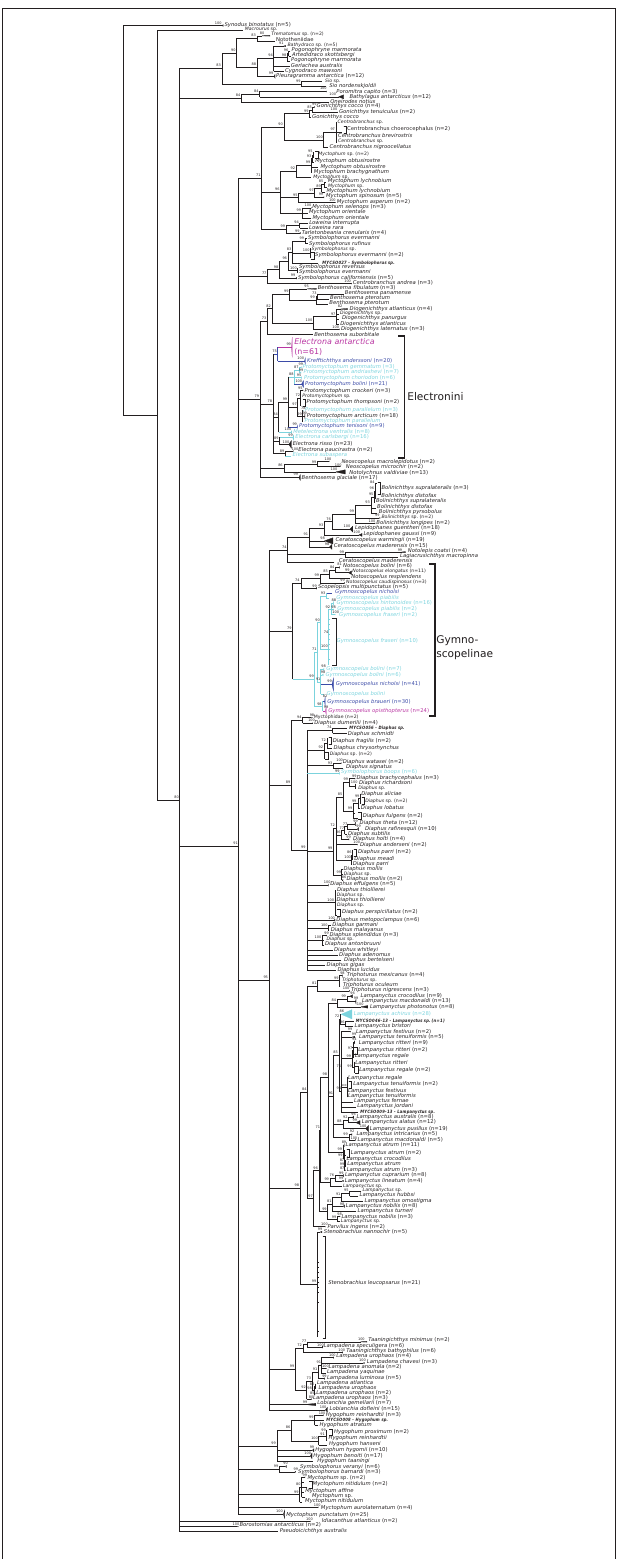
FIGURE 2 | Phylogenetic consensus tree of myctophid fishes based on cytochrome c oxidase I ( COI ) gene variation using a maximum likelihood analysis with 10,000 bootstrap permutations. Bootstrap support > 70 is shown above the branches; branches with lower support are collapsed to polytomies; species with Antarctic, broadly Antarctic, and sub-Antarctic distribution pattern following Duhamel et al. (2014) are depicted in purple, dark blue, and light blue, respectively (please see online version of the article for full-scale, color figure). Number of collapsed samples noted in brackets. Samples where genus level identity was added a posteriori based on position in the tree are noted in bold